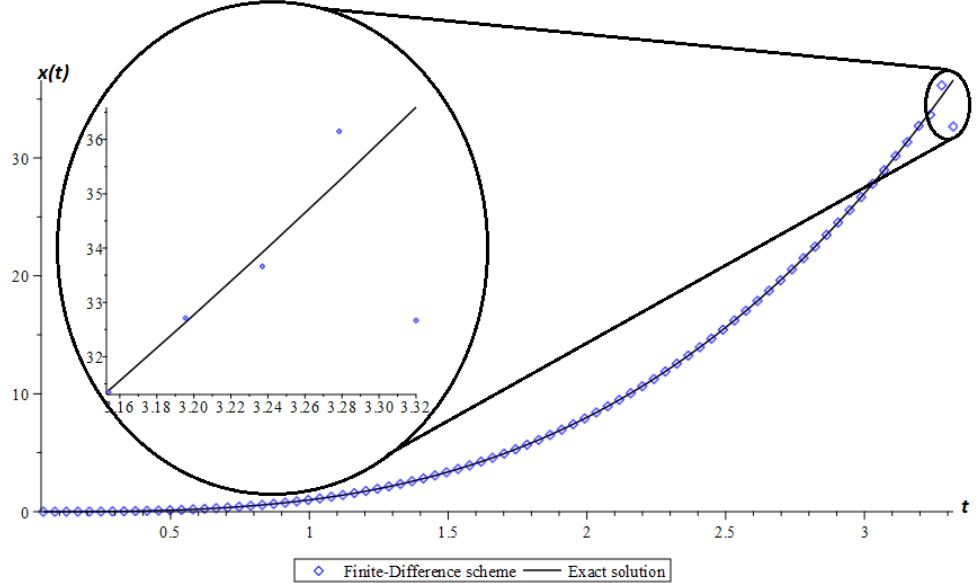
Figure 2. Test example. Numerical and exact solutions of problem (20) when the conditions of Theorems 2 and 3 are not fulfilled.